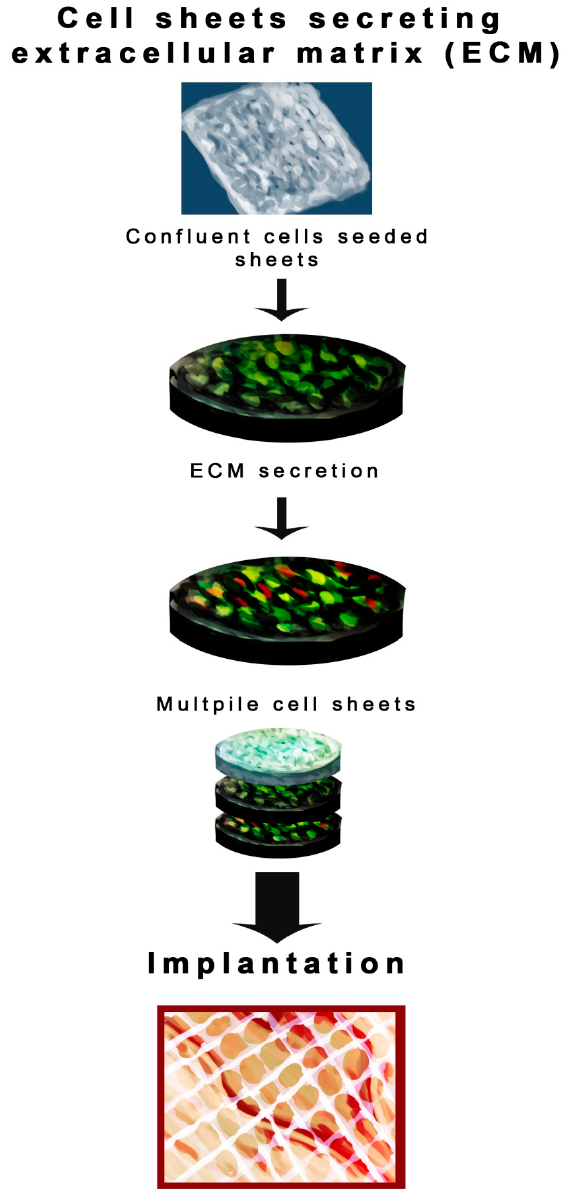
Figure 1. Cell sheets that secret extracellular matrix (ECM). Cells are seeded on the sheets and allowed to secret ECM that facilitates growth and proliferation. Multiple cell seeded sheets capable of secreting ECM are used for implantation at the wound site.